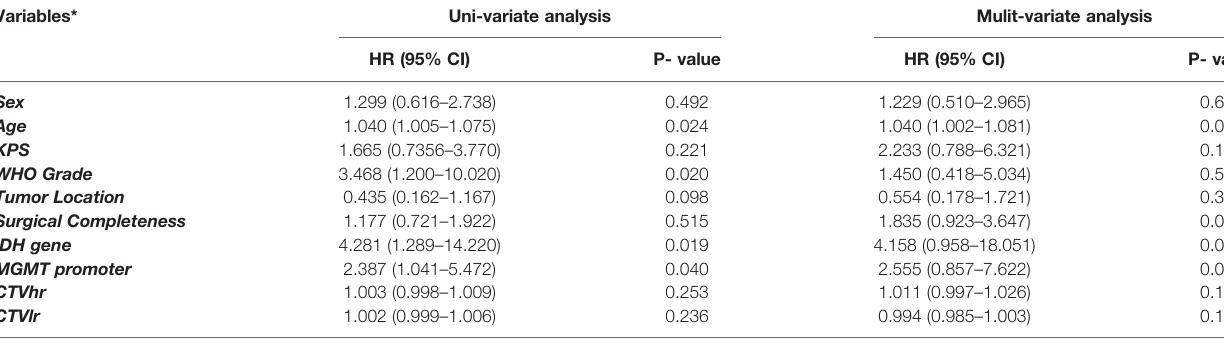
TABLE 2 | Cox proportional hazard regressions for progression-free survival in the training set.